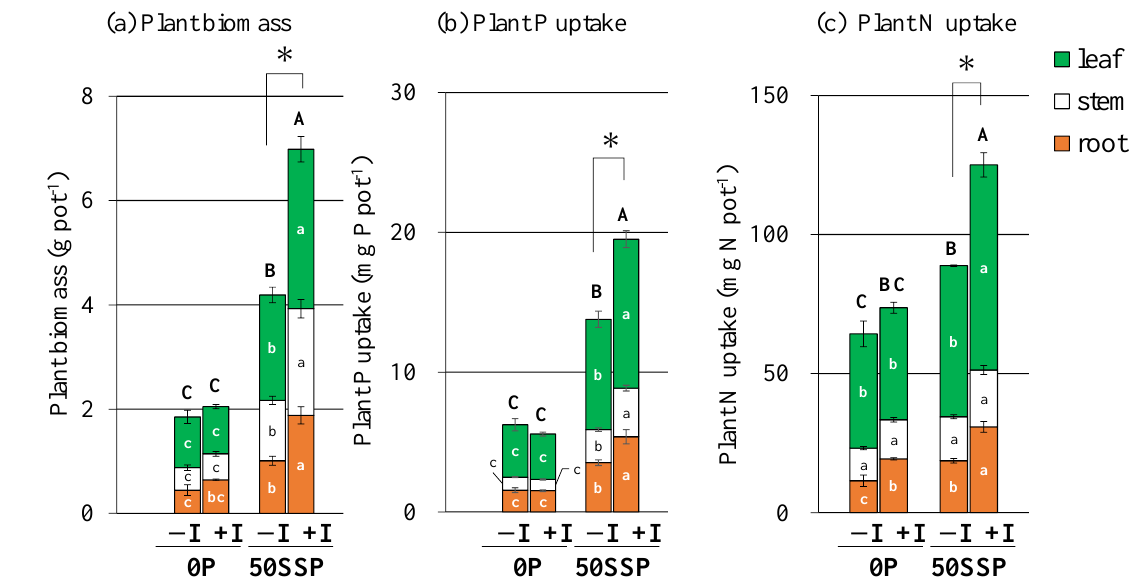
Figure 1. ( a ) Plant biomass, ( b ) Plant P uptake, ( c ) Plant N uptake after pot experiments. − I/+I and 0P/50SSP indicate Rhizobium inoculation and P fertilization, respectively. Bars indicate the standard error ( n = 5). Lowercase letters indicate significant differences in total biomass, plant P uptake, and plant N uptake per pot between the plant parts under each treatment estimated using Tukey’s posthoc test ( p < 0.05). Uppercase letters indicate significant differences in total biomass, plant P uptake, and plant N uptake per pot in each treatment, according to Tukey’s posthoc test ( p < 0.05). * represents significant differences between − I and +I treatments under 0P and 50SSP treatments estimated using Student’s t -test ( p < 0.05). Table 2. Summary of two-way analysis of variance for the effect of Inoculation (I noc ) and P fertilizer (P fer ) on plant biomass, P uptake, and N uptake. Plant Biomass P Uptake N Uptake